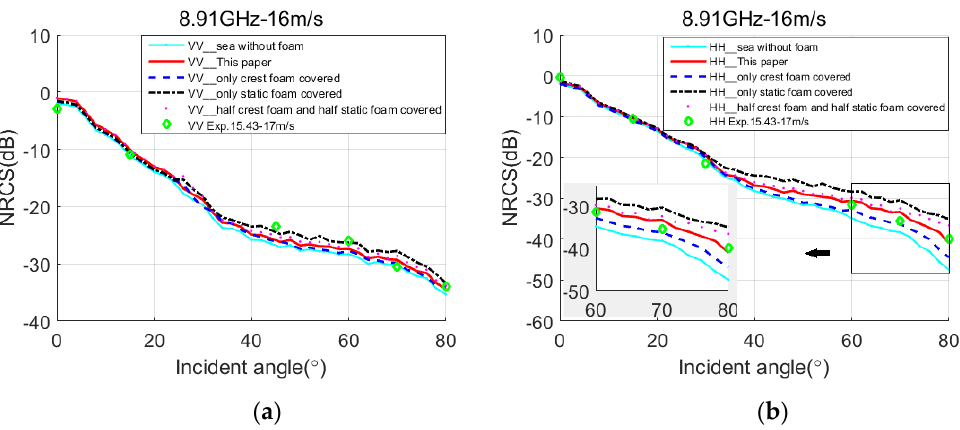
Figure 11. Comparison results of NRCS by the proposed model, the sea surface covered with crest foam only, the sea surface covered with static foam only, the sea surface covered half crest foam and half static foam and the measured data from 4FRS model. f = 8.91 GHz, U 10 = 16 m / s. ( a ) VV polarization. ( b ) HH polarization.